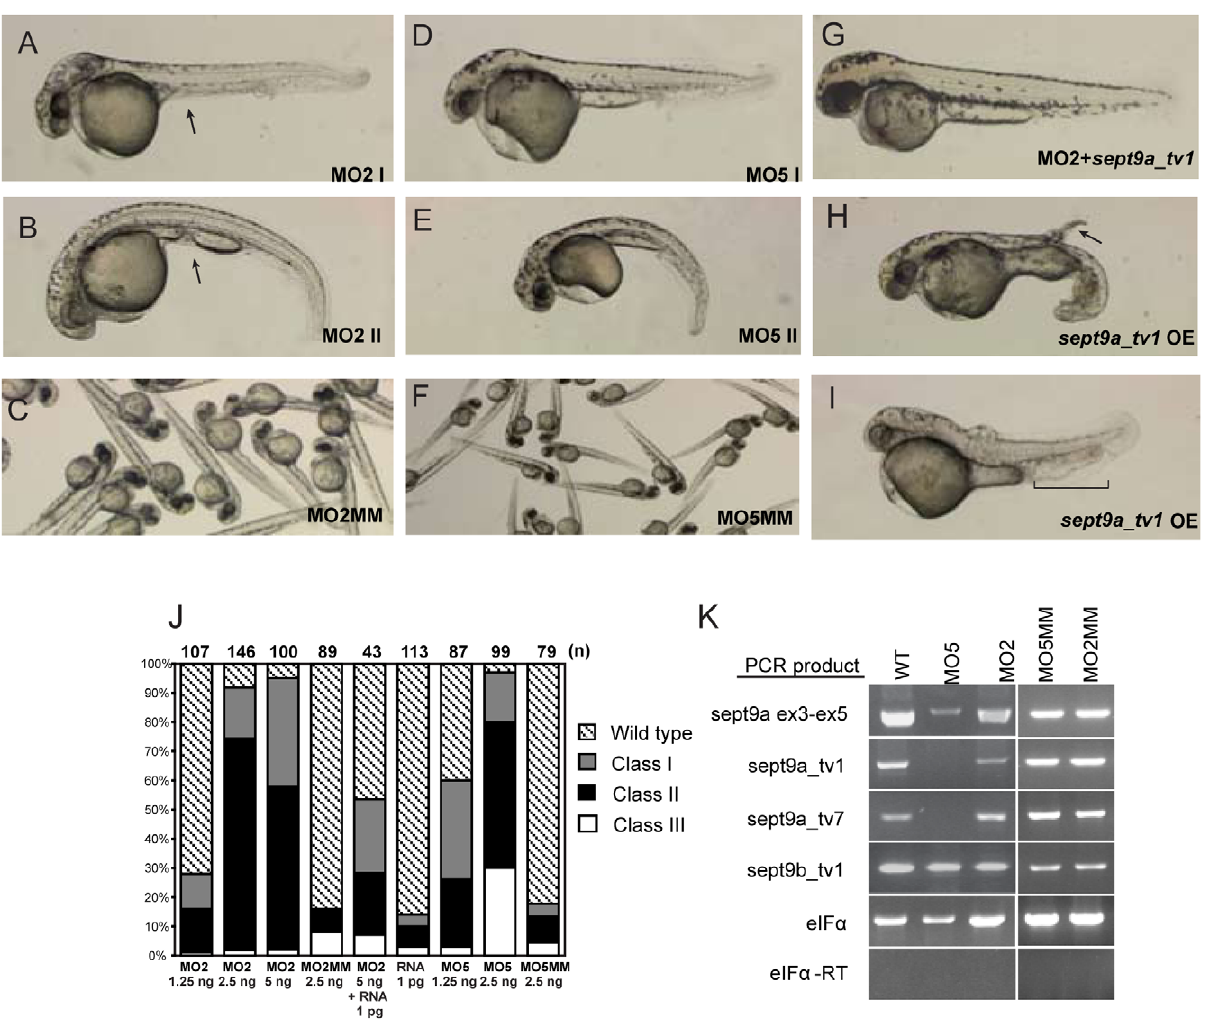
Figure 4. Charaterization of sept9a morphant and overexpression embryos. Embryos were injected at the one-cell stage with morpholinos targeted to all sept9a transcripts (MO5), sept9a_tv1 only (MO2), mismatch controls (MO5MM, MO2MM), or sept9a_tv1 mRNA with and without MO2. Morphants shown were injected with 2.5 ng morpholino. At 48 hpf, the phenotypes were assessed by morphological criteria, according to severity. A,D : Class I morphants had defects in epidermal integrity and yolk extension and minor curvature of the tail. B,E : Class II morphants had a curved body axis in addition to the defects observed in class I. Class III morphants had a severely shortened body axis (data not shown). Arrows indicate yolk extension defects. All classes exhibited defects in blood circulation. G : Coinjection of 1 pg of sept9a_tv1 mRNA with 5 ng of MO2 partially rescued the observed phenotypes. H,I : Embryos injected with as little as 4 pg of sept9a_tv1 mRNA often had phenotypes similar to those of sept9a morphants including epidermal aggregates (arrow), blood pooling, and tail edema (bracket). (OE) indicates over expression. C,F : Control mismatch morpholinos did not present a phenotype. J : Graphical representation of MO classes at various concentrations. The number of embryos tested in each experiments is indicated by (n) on top of each column. K : sept9a splice morpholinos inhibit sept9a transcript splicing. RT-PCR analysis was performed on 24 hpf wild-type embryos, embryos injected with 2.5 ng MO5 or MO2 (pooled classes I and II), or 5 bp mismatch controls. MO5 embryos show a complete loss of sept9a_tv1 and sept9a_tv7 . The presence of a low level of sept9a exons 3–5 transcripts in MO5-injected embryos may be due to maternal mRNA. MO2 embryos show a decrease in sept9a_tv1 compared to wild-type while the other transcripts are not affected.